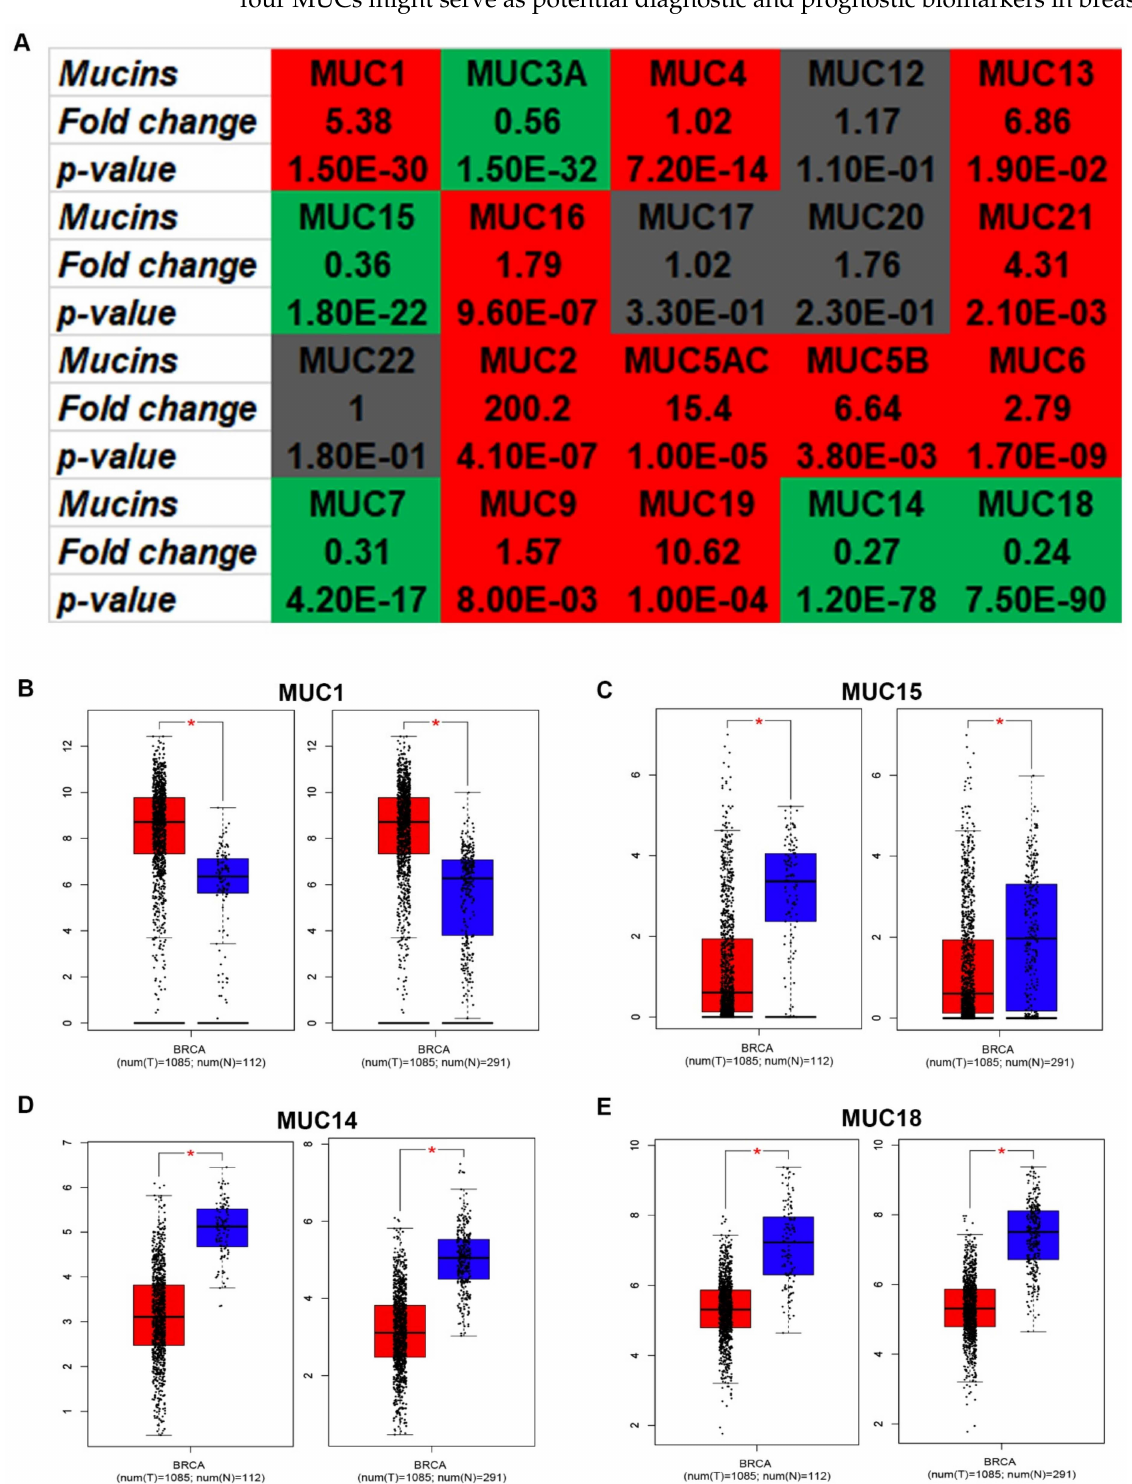
Figure 1. The mRNA expression of MUCs in breast cancer. ( A ) The mRNA expression landscape of MUCs in breast cancer determined by starBase. Red: high expression; green: low expression; grey: no statistical difference. The expression of MUC1 ( B ), MUC15 ( C ), MUC14 ( D ) and MUC18 ( E ) in breast cancer determined by GEPIA. * p -value <